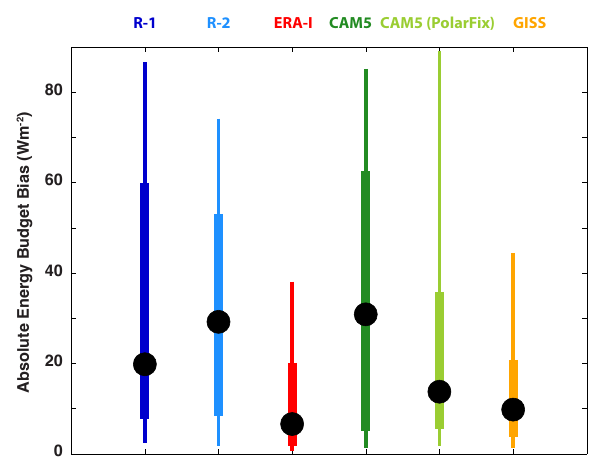
Fig. 7. Combined distributions of the absolute values of biases in LW up , LW down , SW up , SW down , F SH and F LH . Distributions are depicted, including the median (black dot), IQR (wide bar) and 10th–90th percentiles (thin